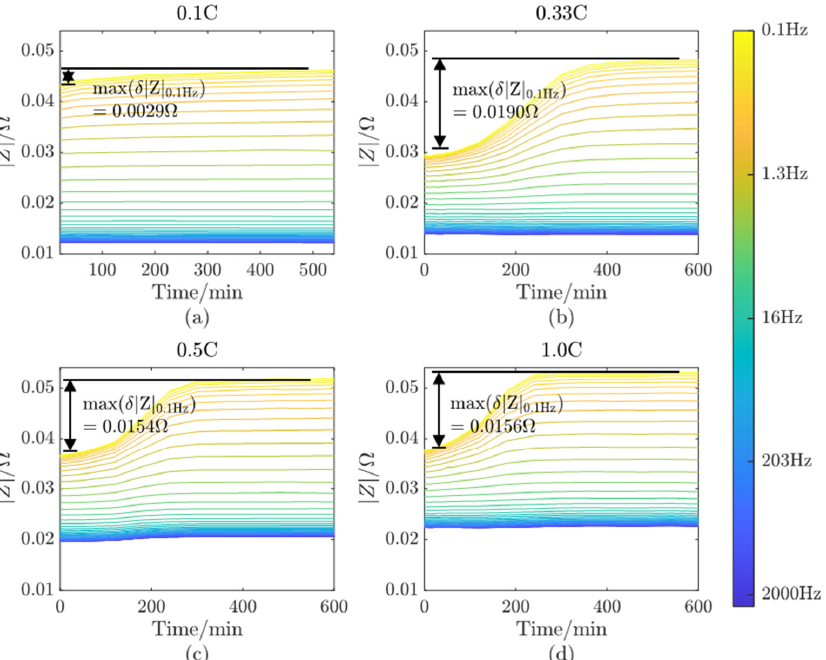
Figure 4. The impedance values at different frequencies of ( a ) experiment #1-1; ( b ) experiment #1-2; ( c ) experiment #1-3; ( d ) experiment #1-4.